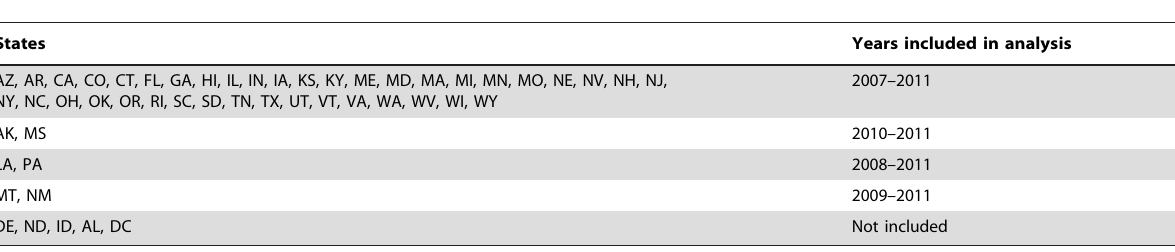
Table 1. Years and states included in